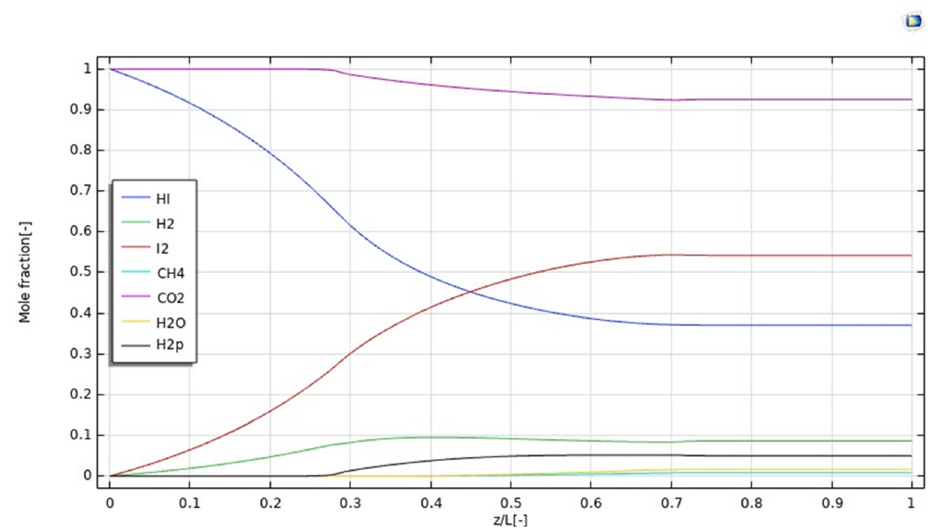
Figure 5. Reactants and products distributions along z-axis in the MMR at T = 400 °C, 1 bar, feed flow rate = 20 mm 3 /s, and sweep gas flow rate = 333.33 mm 3 /s.